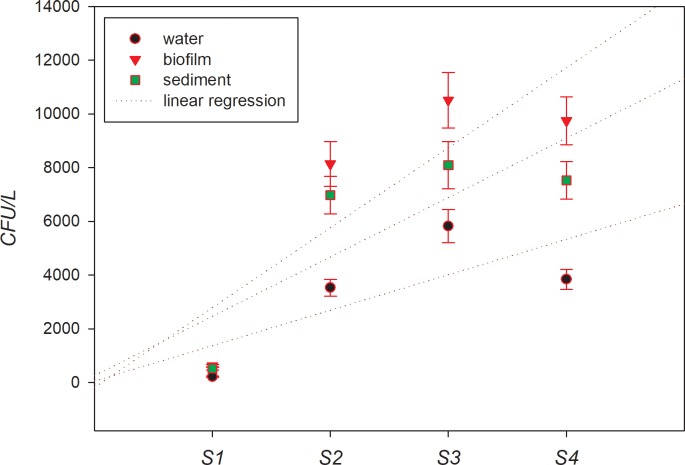
Concentration of fecal coliforms (FC) in samples from Weihe-river.